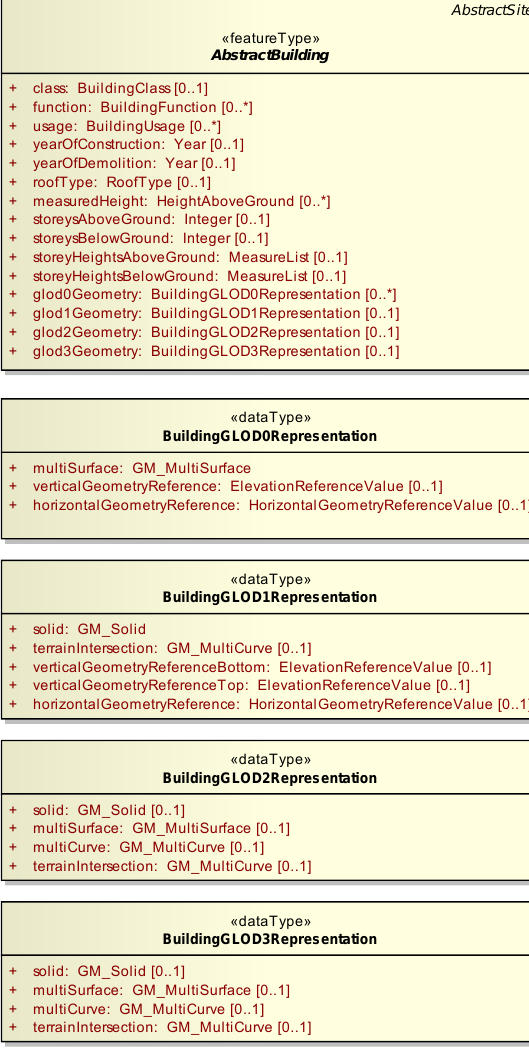
Figure 9: Proposal for class AbstractBuilding The UML representation of the Room class (Figure 11) is similar to AbstractBuilding . With exception of a missing TerrainIntersectionCurve , the data types BuildingLODx - Representation and RoomLODxRepresentation are identical.